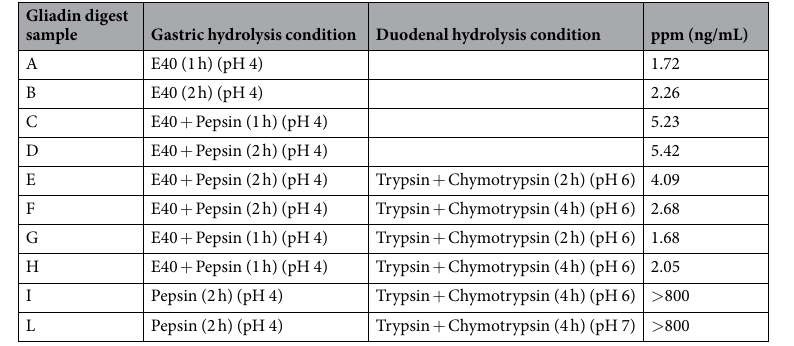
Table 1. Enzymatic digestion scheme of gliadin proteins by pepsin-trypsin/chymotrypsin and E40, and determination of gluten content of digested gliadin sample A-L (see Table 1) by G12-Elisa